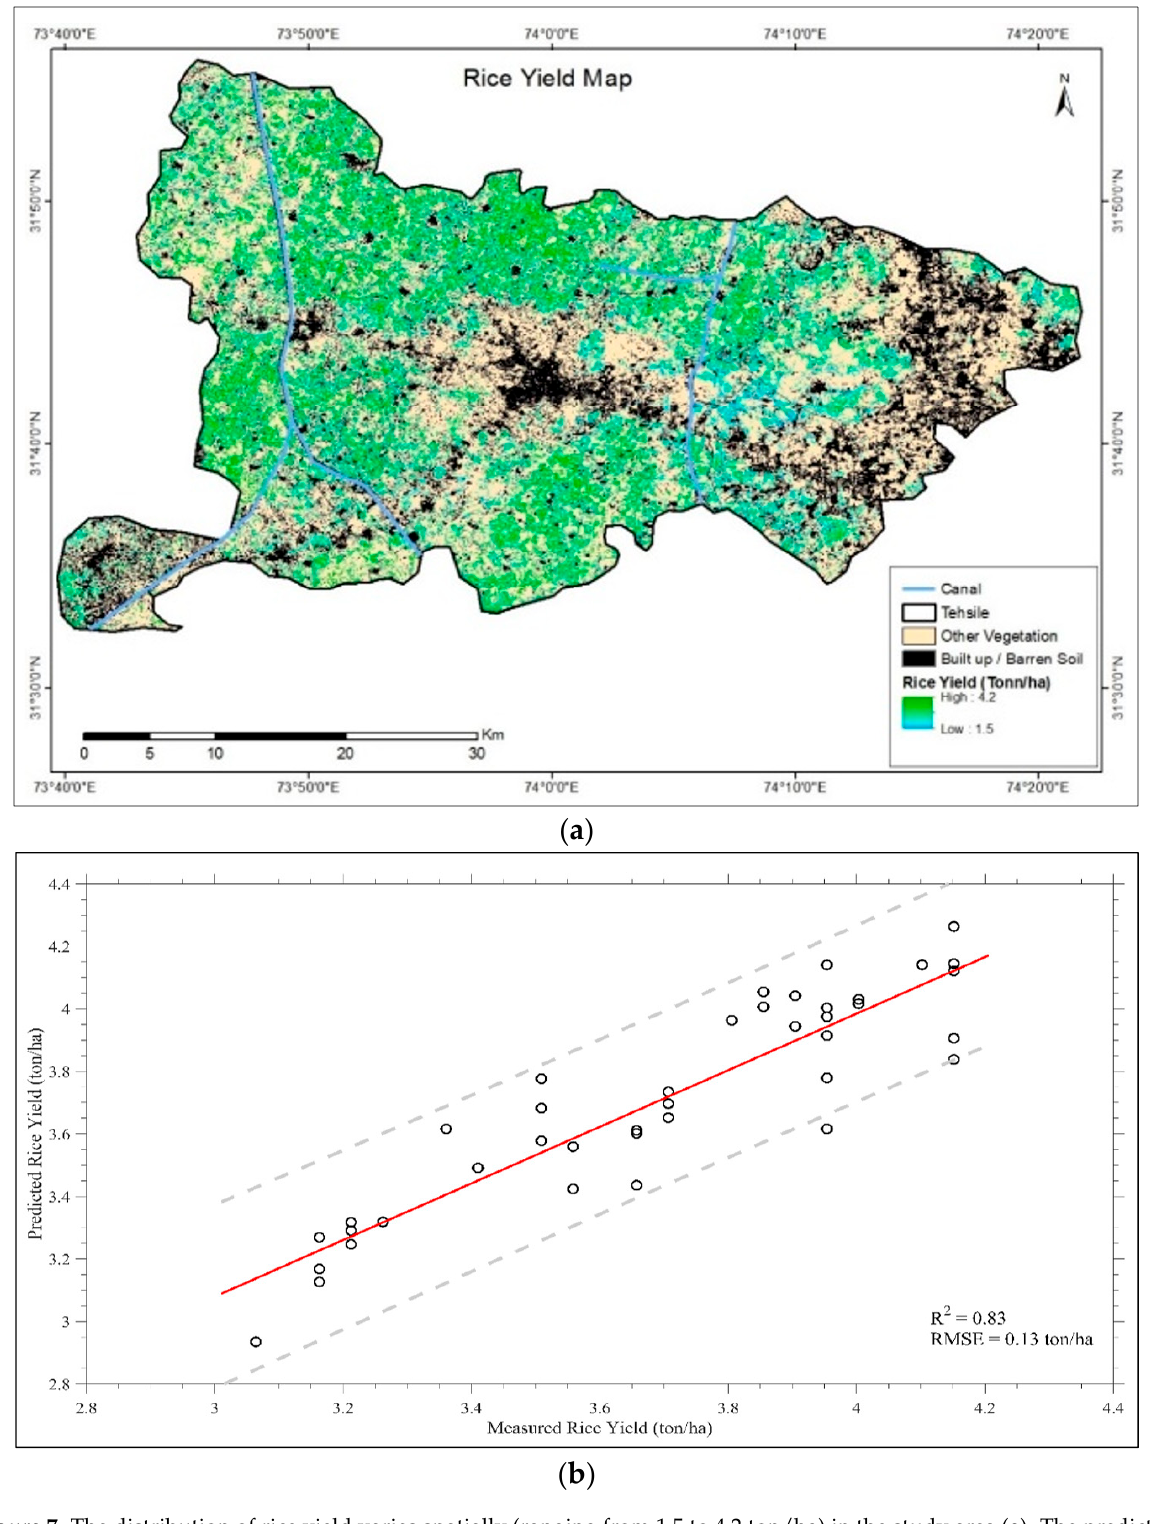
Figure 7. The distribution of rice yield varies spatially (ranging from 1.5 to 4.2 ton/ha) in the study area ( a ). The predicted yield (based on distribution map) shows strong relation with measured yield ( b ).